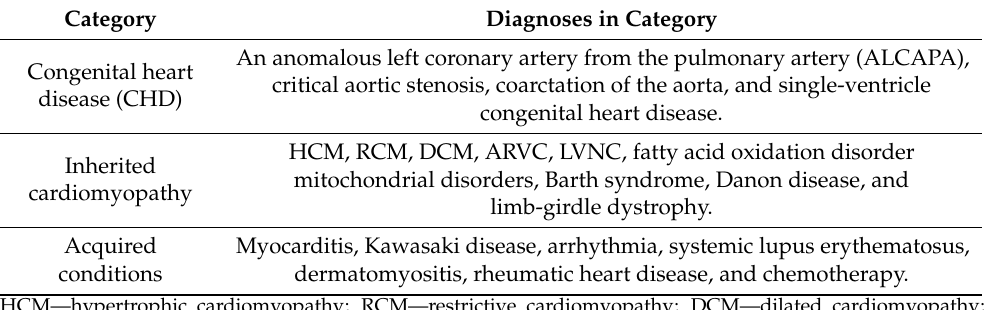
Table 1. Main causes of pediatric heart